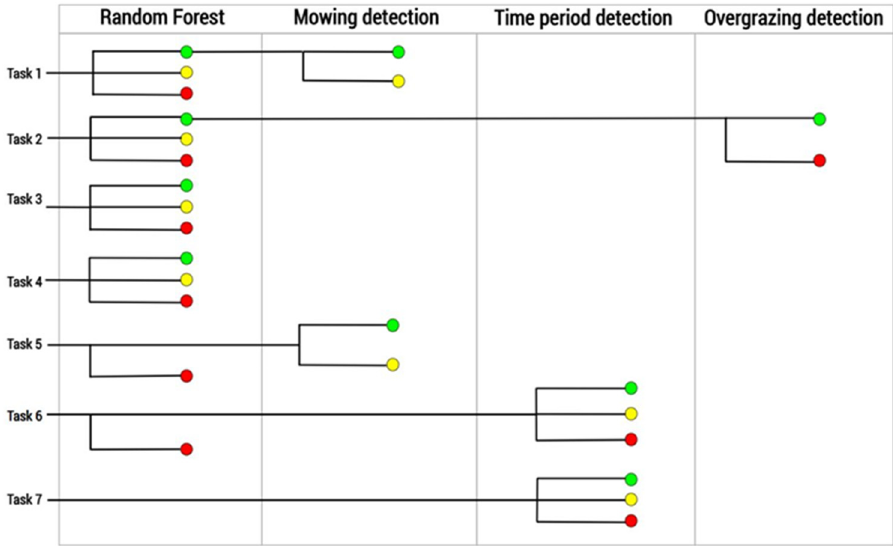
Figure 10. Decision tree plot of the rules resulting in a decision for each of the monitoring tasks based on the data analysis steps. Green circle: Parcel is compliant to requirements of the task; Yellow circle: Parcel is uncertain, needs following up (field or imagery); Red circle: Parcel is confirmed to be non-compliant.